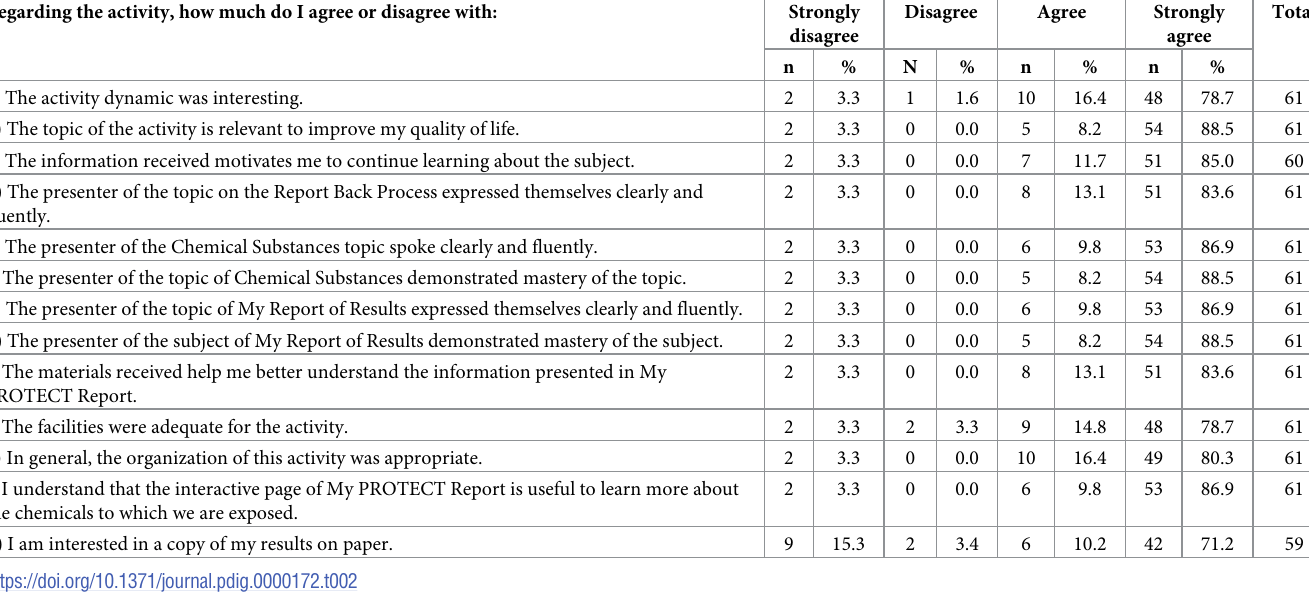
Table 2. Participants in the report-back activity (N =